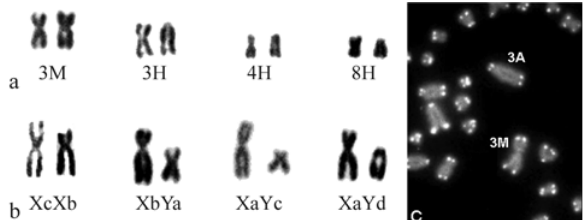
Figure 3 - (a) Variation of autosome pairs 3, 4 and 8: H = heteromorphic, and M = metacentric; (b) interindividual variability of the sex chromo- somes; (c) fluorescence in situ hybridization with a telomeric probe re- vealed signals only at the telomeres of the heteromorphic pair